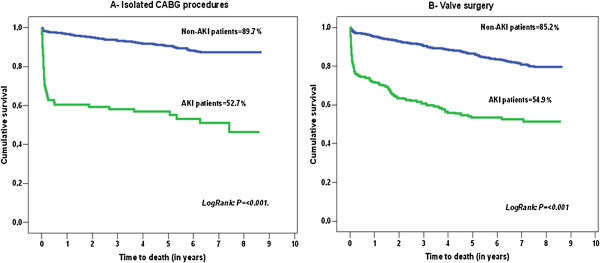
Kaplan-Meier survival curves for AKI patients stratified by individual surgery type (A and B).